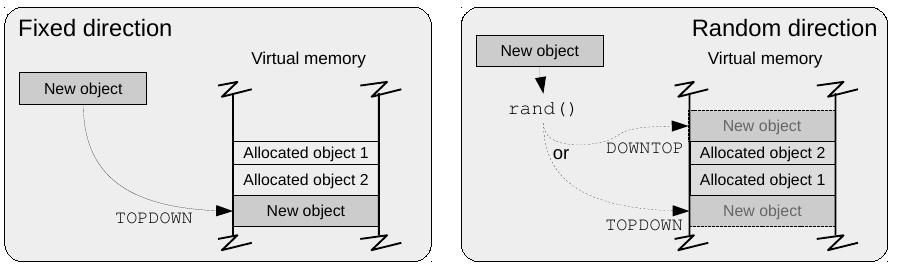
Figure 6. Direction of allocation.